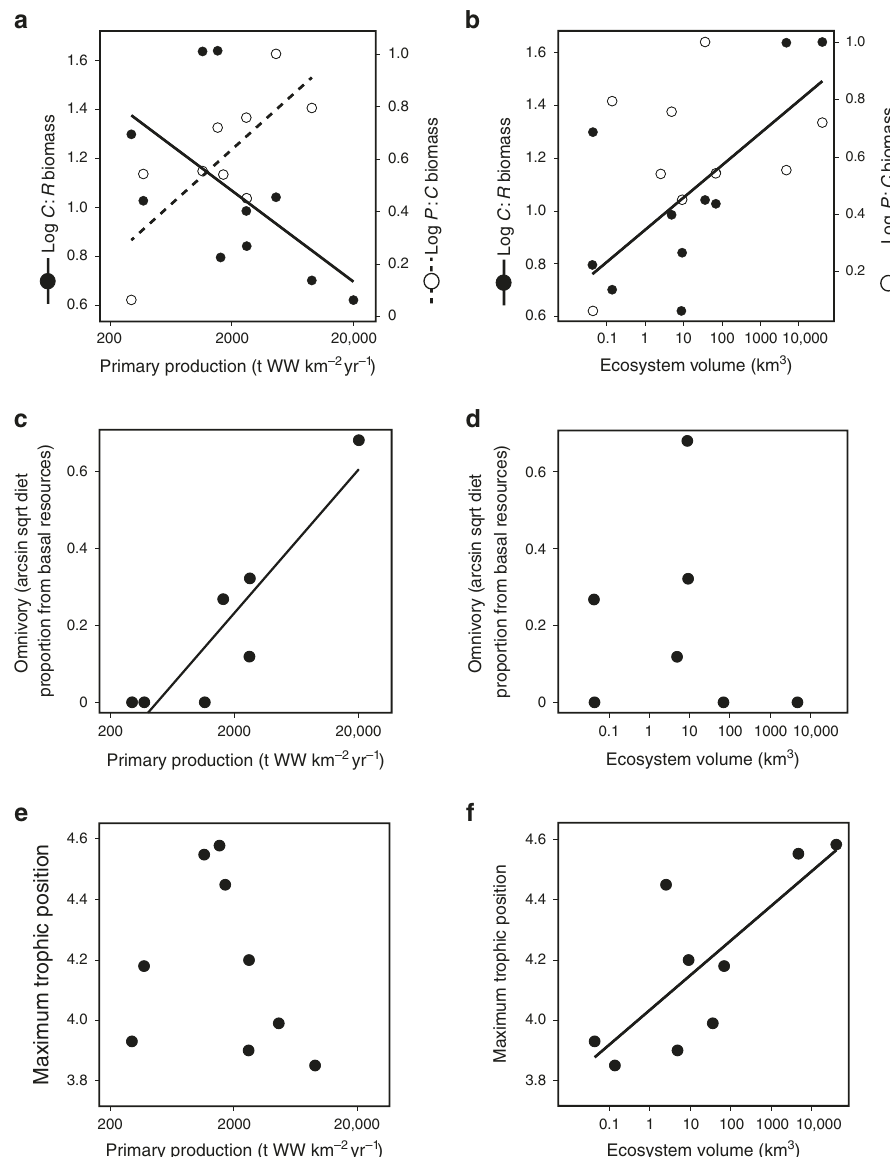
Fig. 4 Evaluating support for the Energy Flux Mechanism for FCL (predictions in Fig. 1) in marine bounded ecosystems. Relationships between the log ratios of C : R biomass (solid lines) and P : C biomass (dashed lines) and a total primary production and b ecosystem size. The relationship between omnivory among fi sh 35 – 40 cm and c total primary production and d ecosystem size. The relationship between food chain length and e total primary production,